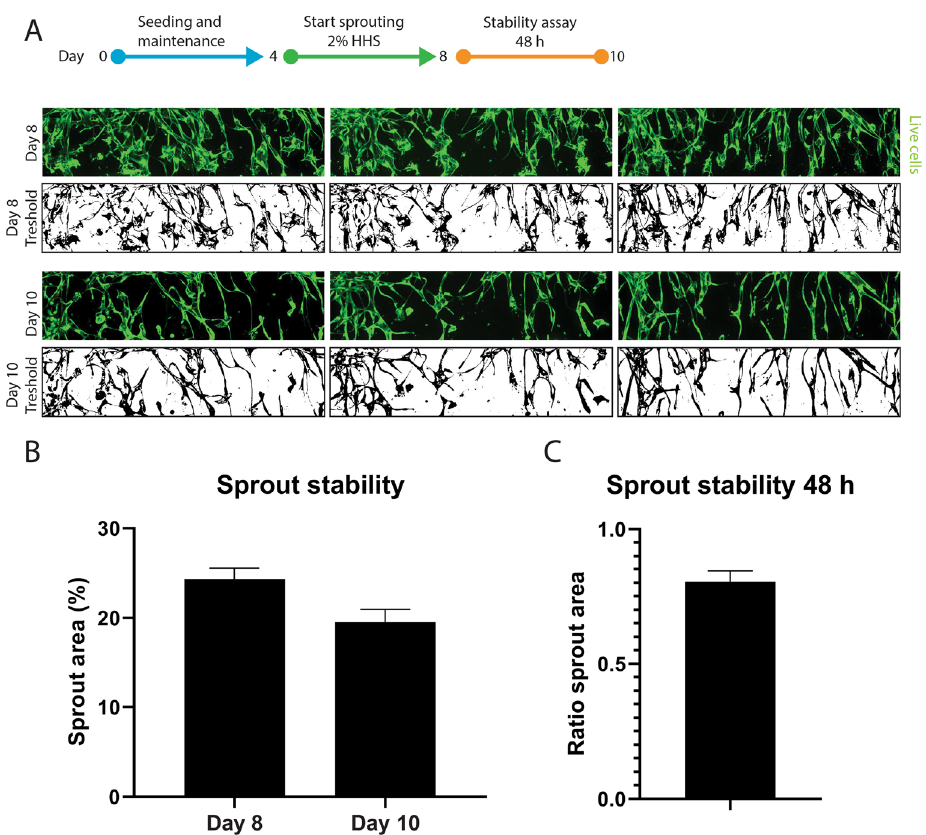
Figure 2. Stability assessment of sprouted HMVEC microvessels. ( A ) Representative maximum projection confocal images (top) and threshold images (bottom) used for quantification of the sprouting area. ( B ) Quantification of the area covered by sprouts at the start (day 8) and end (day 10) of the stability assay (n = 9, represented is mean ± SEM). ( C ) Ratio of the area covered by sprouts at day 10 versus day 8 (n = 9, shown is mean ±